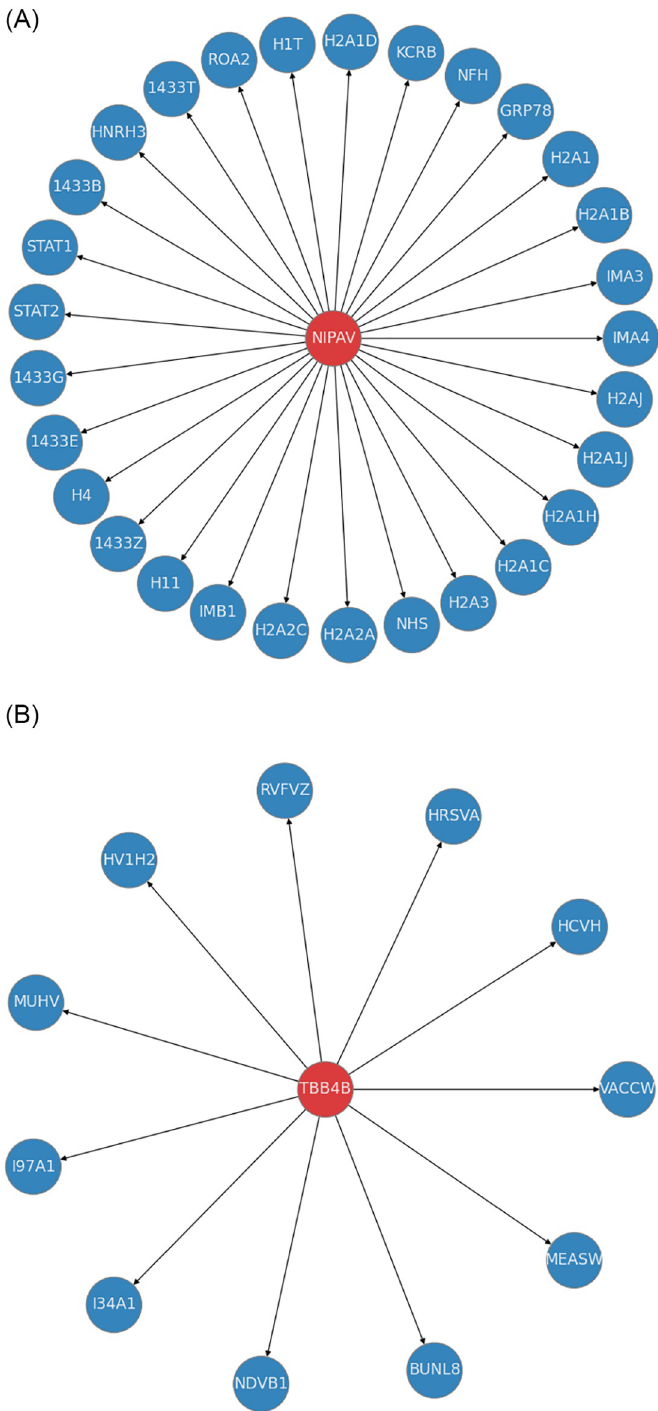
Fig 9. Nipah virus (Acronym: Nipav, identifier: P0C1C7) interactions with multiple human proteins and human protein Tubulin beta-4B (Acronym: TBB4B identifier: P68371) interactions with multiple virus proteins. Here only Short Names of Viruses and Human Proteins are Mentioned. Complete Details of Short names, Scientific Names, and PMIDs of Multiple Human and Virus Proteins are provided in S1 Data. (a) Virus P0C1C7 interactions with multiple human proteins. (b) Human Protein P68371 interactions with multiple viruses.